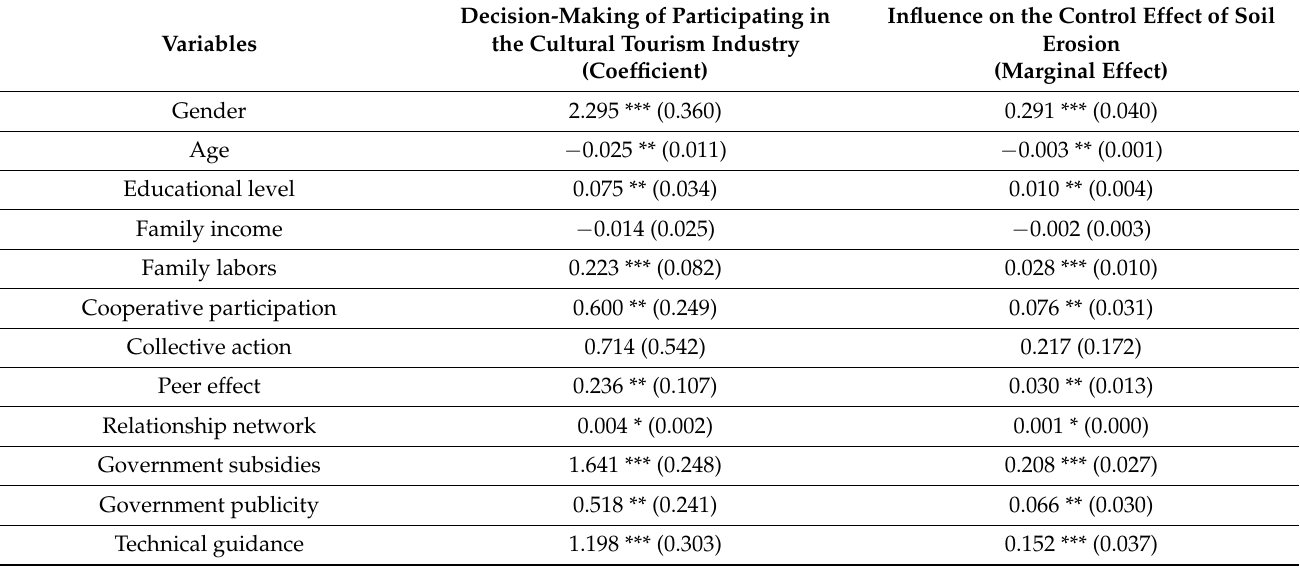
Table 2. Analysis results of Logit model of residents’ participation in the cultural tourism industry and its